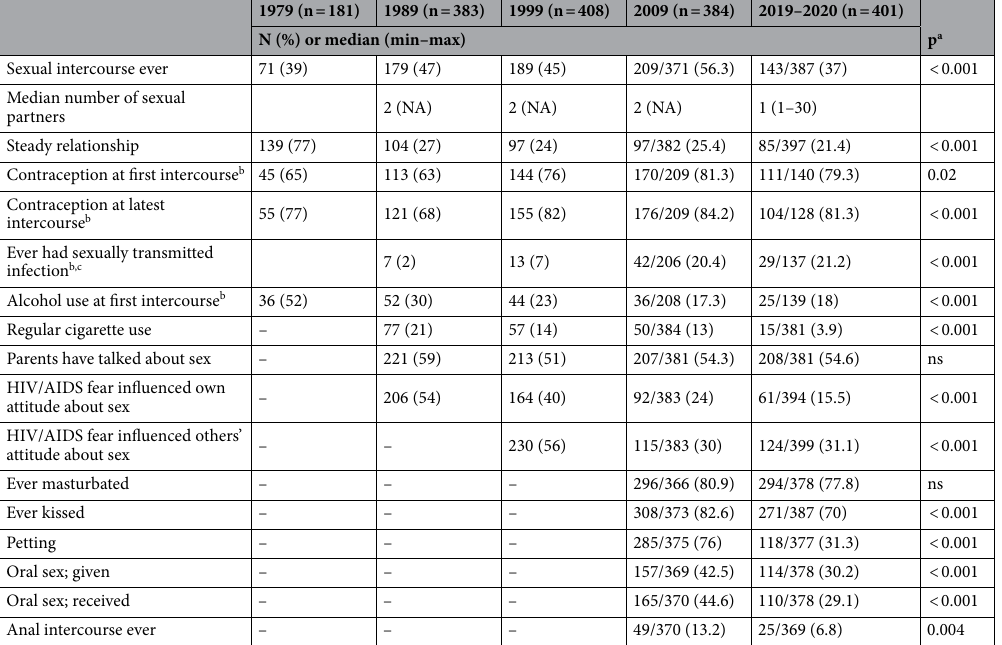
Table 4. Differences in sexual behavior and risk factors among first-year high school students over time. a Pearson chi-square, Fisher’s exact test. b Calculated among those who have had intercourse, NA = not available data. c In 1989 and 1999 the wording was: ‘Did you ever have a STI diagnosed?’ while in 2009 as well as the present study the question was ‘Have you ever suspected that you had a sexually transmitted